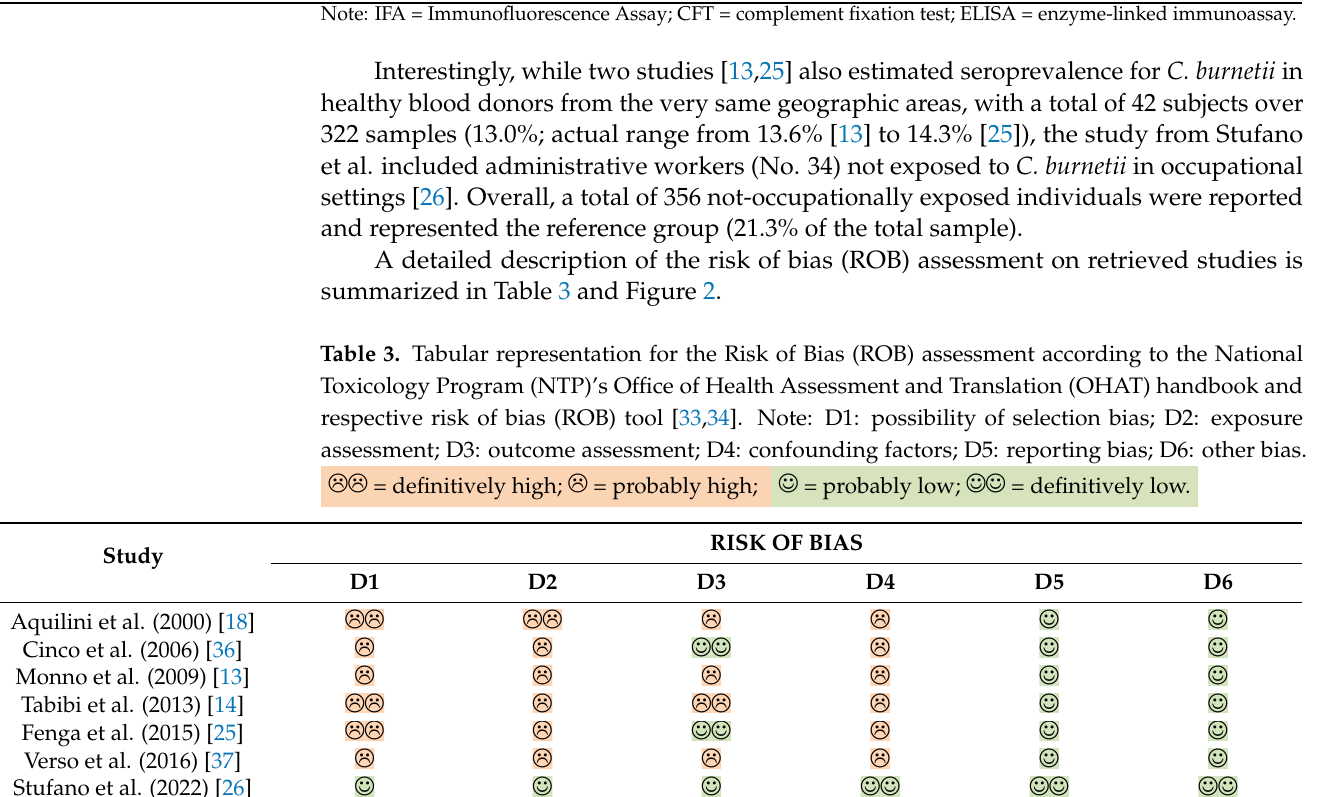
Zoonotic Dis. 2023 , 3 , FOR PEER REVIEW